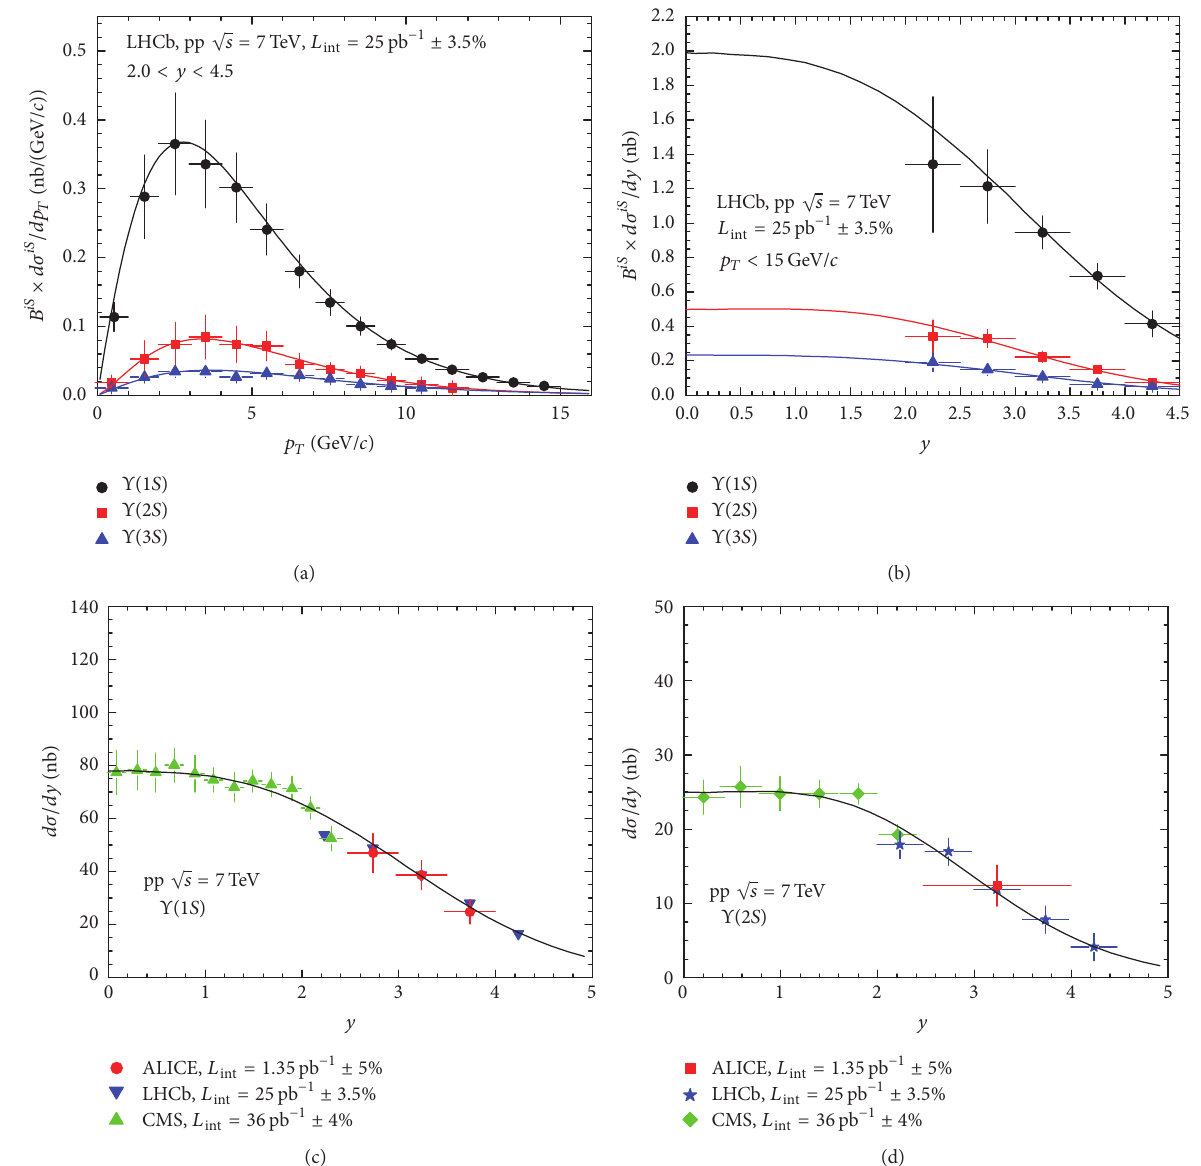
Figure 8: (a) Transverse momentum spectra and (b) backward (forward) region rapidity spectra of bottomonium 𝑏𝑏 mesons Υ(1𝑆) , Υ(2𝑆) , and Υ(3𝑆) , as well as whole space rapidity spectra of (c) Υ(1𝑆) and (d) Υ(2𝑆) mesons produced in pp collisions at √𝑠 = 7 TeV, where 𝜎 𝑖𝑆 and 𝐵 𝑖𝑆 on the vertical axis in (a)-(b) denote the cross section and branching fractions of Υ(𝑖𝑆) ( 𝑖 = 1, 2, and 3), respectively. The closed symbols represent the experimental data of the LHCb [35], ALICE [30], and CMS Collaborations [36, 37]. The error bars in (a)-(b) are the total uncertainties which combine the systematic and statistical uncertainties to be equal to their root-sum-square, and the error bars in (c)-(d) are only the systematic uncertainties. The curves are our results calculated by using the hybrid